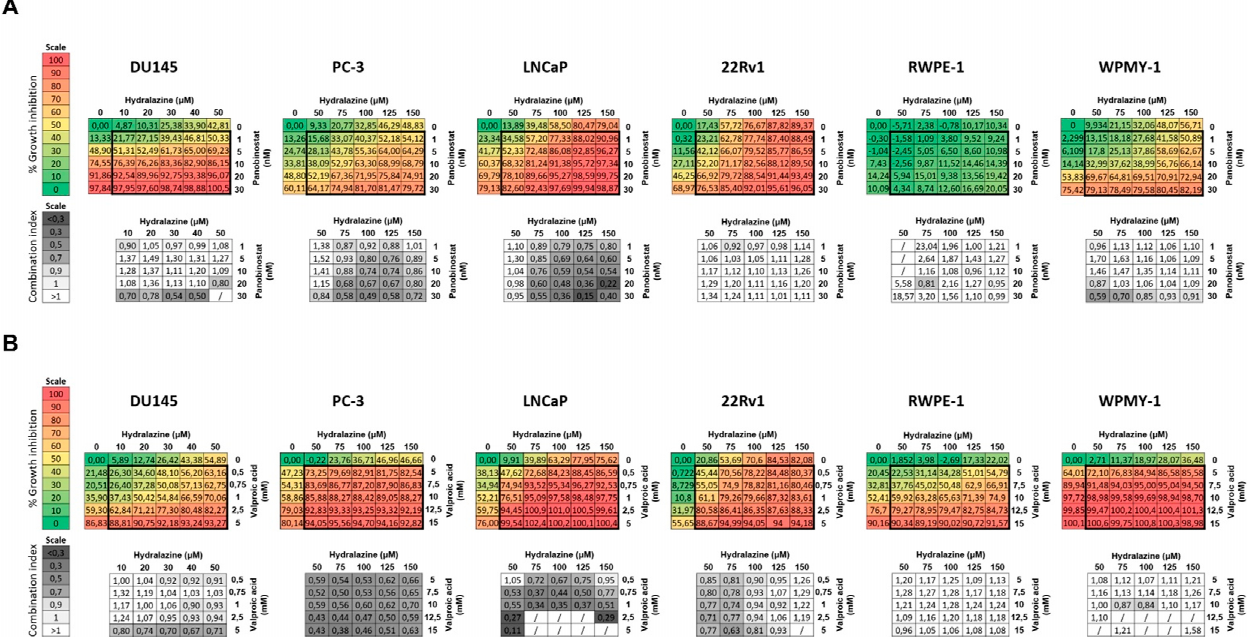
Figure 2. Combination matrix. Cells treated with hydralazine and panobinostat ( A ) or valproic acid ( B ) at the indicated concentrations for three days. Each plate contained 6 × 6 dose matrix blocks with several concentrations of both drugs. Percentage of growth inhibition was calculated for each epidrug combination using resazurin and are representative of three biological replicates ( n = 3). The combination index (CI) was calculated using CompuSyn software, where <1 indicates synergism, =1 is additive effect and >1 indicates antagonism. The percentage and color codes for growth inhibition and CI scales are shown on the left. The results that CompuSyn could not convert into CI, since the effect values were not between 0 and 1, are represented by /. Table 1. Selected concentrations utilized in the functional assays. Each combination was selected according to each cell line EC 50 and the CI values.